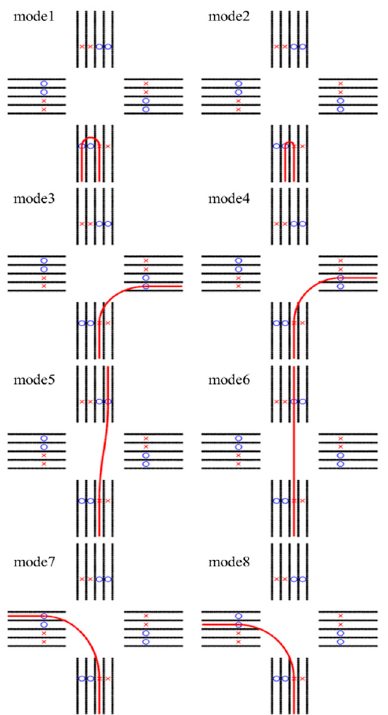
Figure 1. Eight modes of possible behavior of the target approaching the intersection by using the leftmost lane from the south.